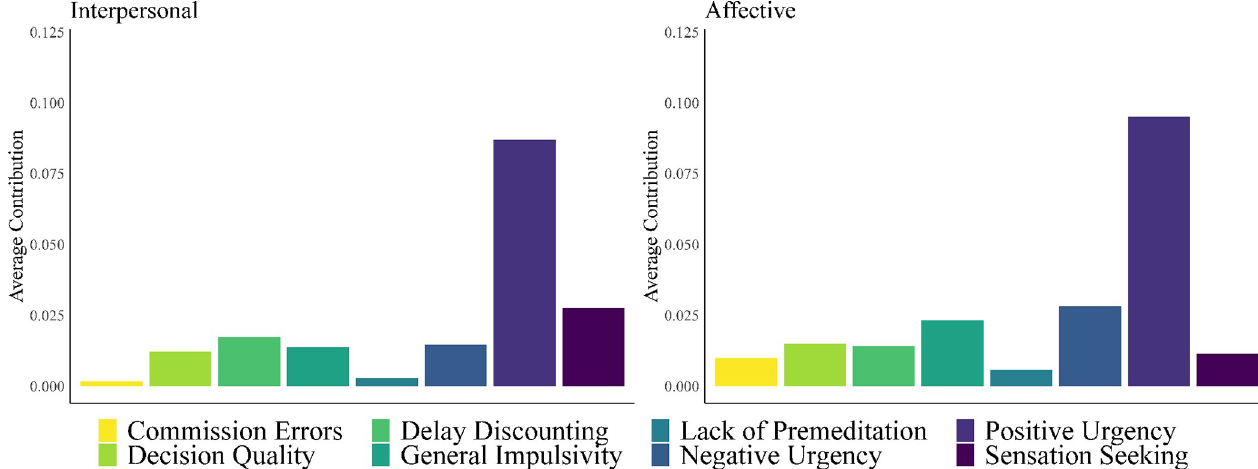
Fig 1. General dominance plots of the average contribution (via R 2 ) of each predictor of the interpersonal (left) and affective (right) facets of psychopathy.